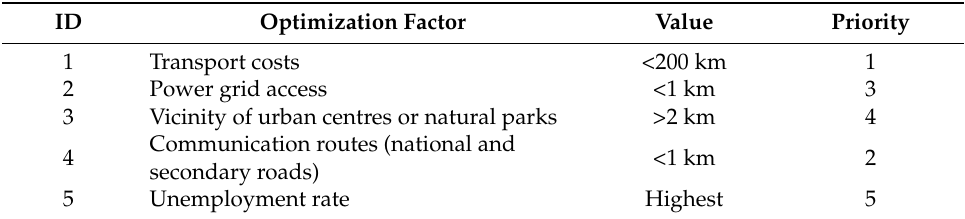
Table 6. Optimization